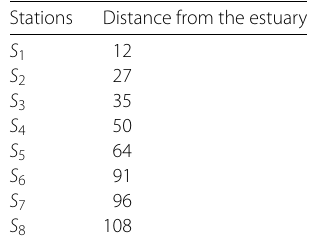
Table 1 Water quality monitoring stations in river, Thailand where S 7 is the main water supply pumping station for